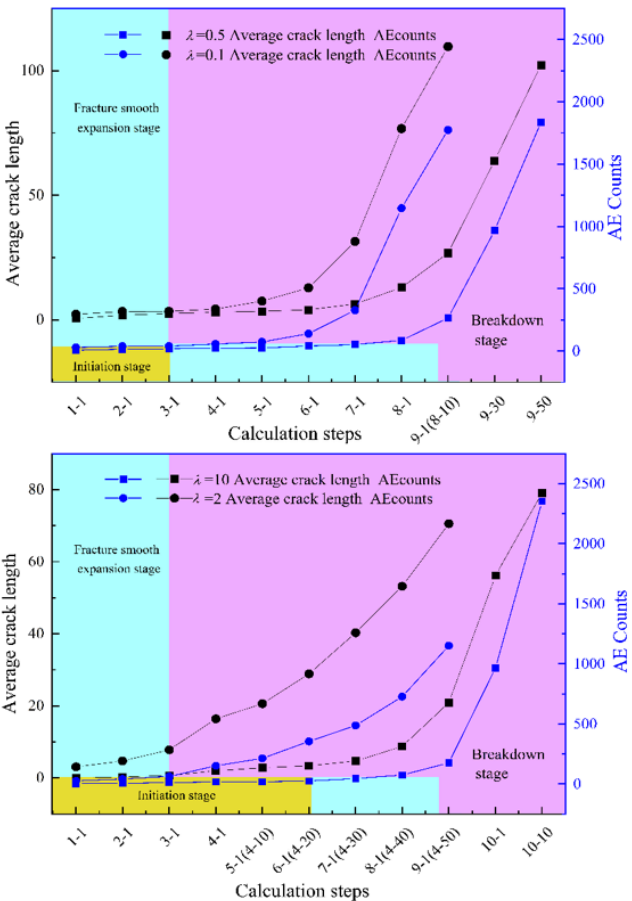
Figure 13. Cumulative crack length and AE counts of fracturing hole change with calculation time step under different λ when ξ = 0.5.